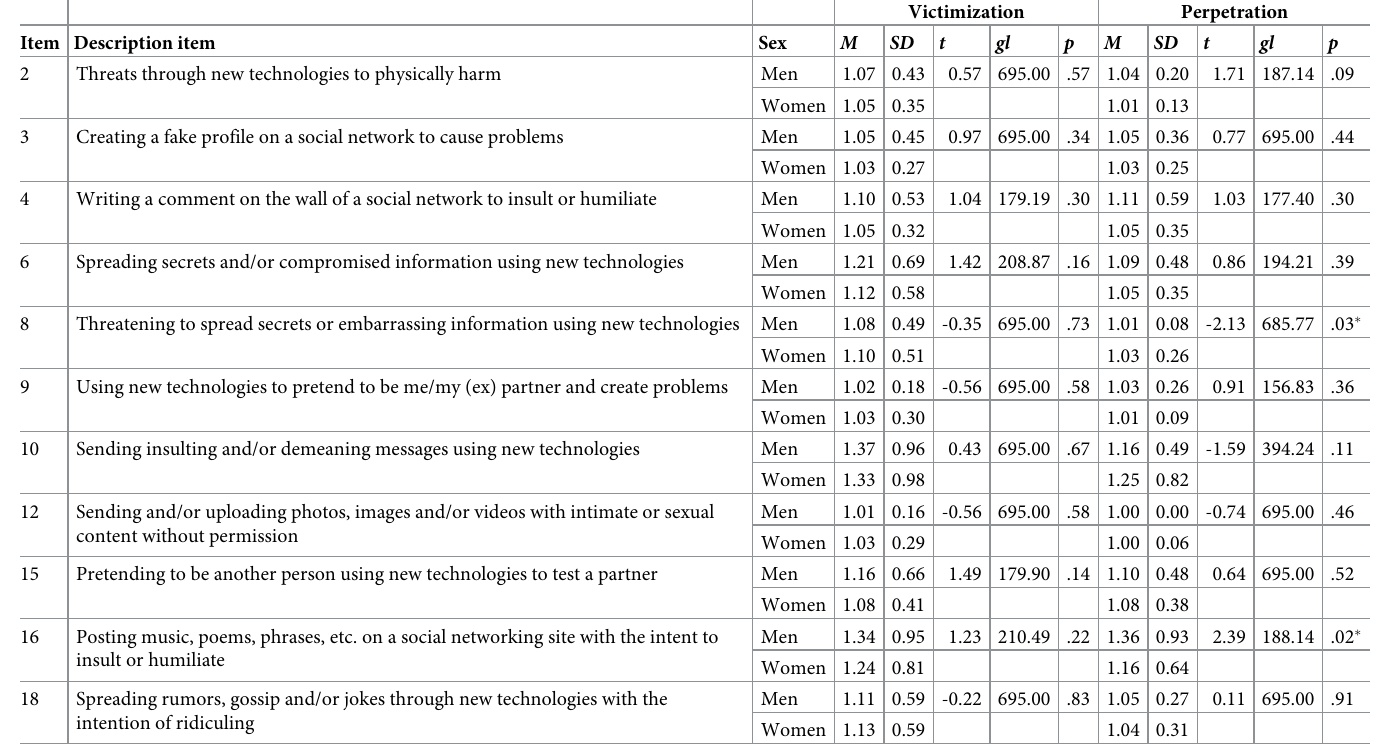
Table 4. Sex-related differences for each item of the direct aggression subscale, for both victimization and perpetration.